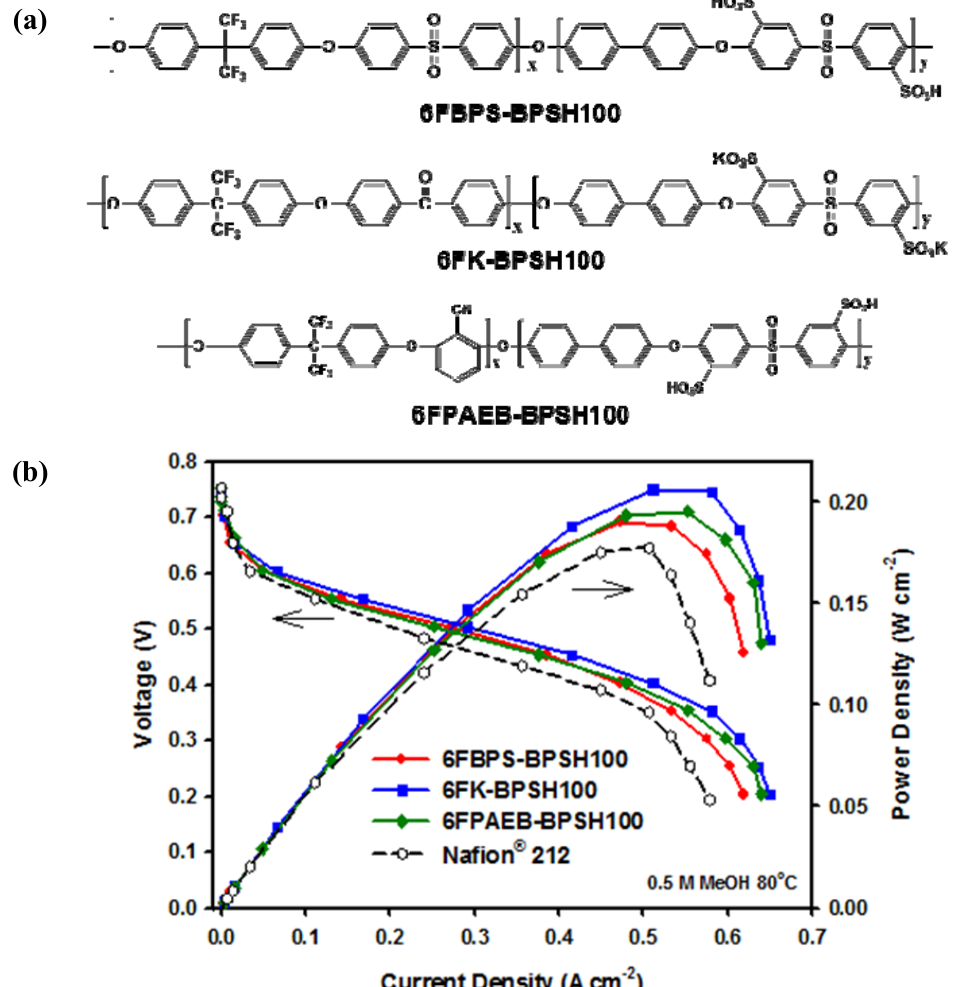
Figure 13. ( a ) Multiblock copolymers for DMFC membranes with reduced crossover; ( b ) Comparison of fuel cell performance for several multiblock copolymers shown in ( a ) compared to Nafion 212 ® demonstrating improved performance as the 6F:BP ratio is tuned